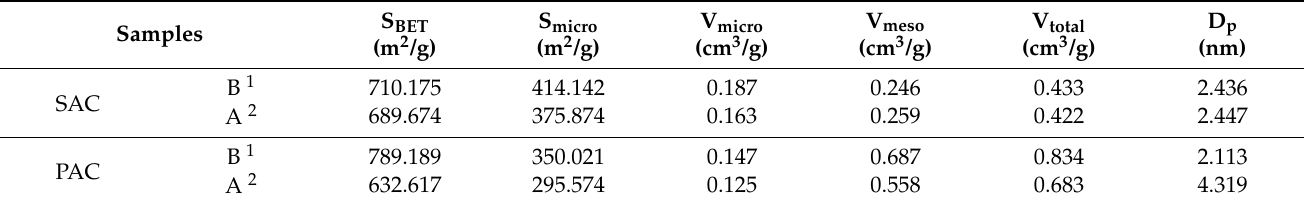
Table 2. Specific surface area and pore size parameters of SAC and